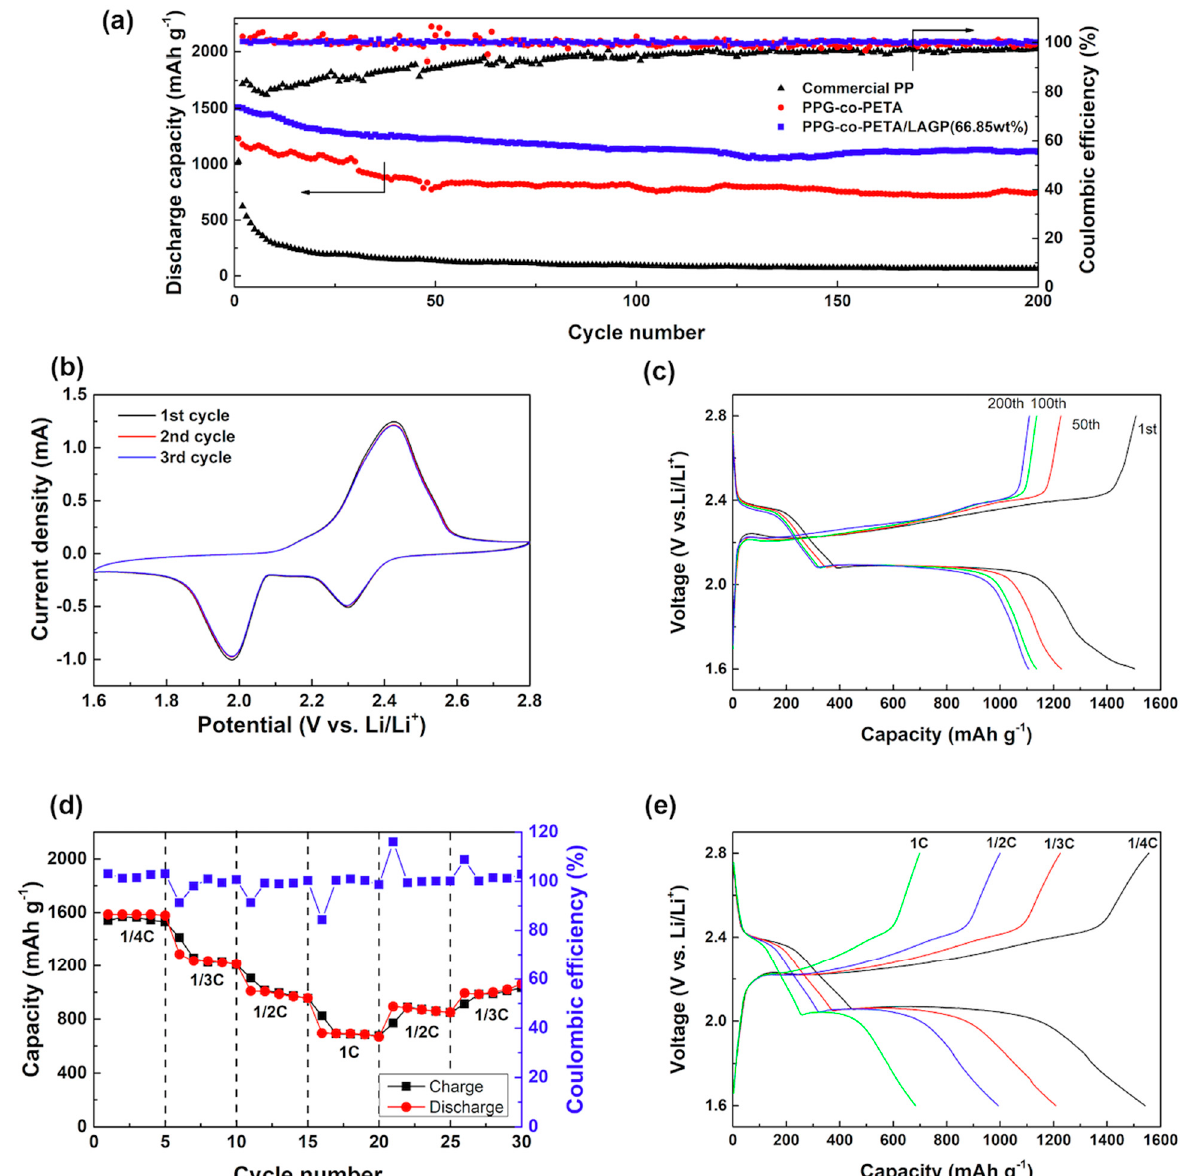
Figure 4. ( a ) The cycling performances of the Li-S battery using QSSCE compared with using PPG-co-PETA electrolyte and PP separator at the current of 0.25 C. ( b ) The CV curves of the QSSCE, collected in the potential from 1.6 to 2.8 V (vs. Li/Li + ) at a scan rate of 0.1 mV/s. ( c ) The galvanostatic charge/discharge curves of the QSSCE at the current of 0.25 C at different cycles. ( d ) The rate performances of the QSSCE. ( e ) The charge/discharge curves of the QSSCE under the currents of 1/4, 1/3, 1/2 and 1 C, respectively.